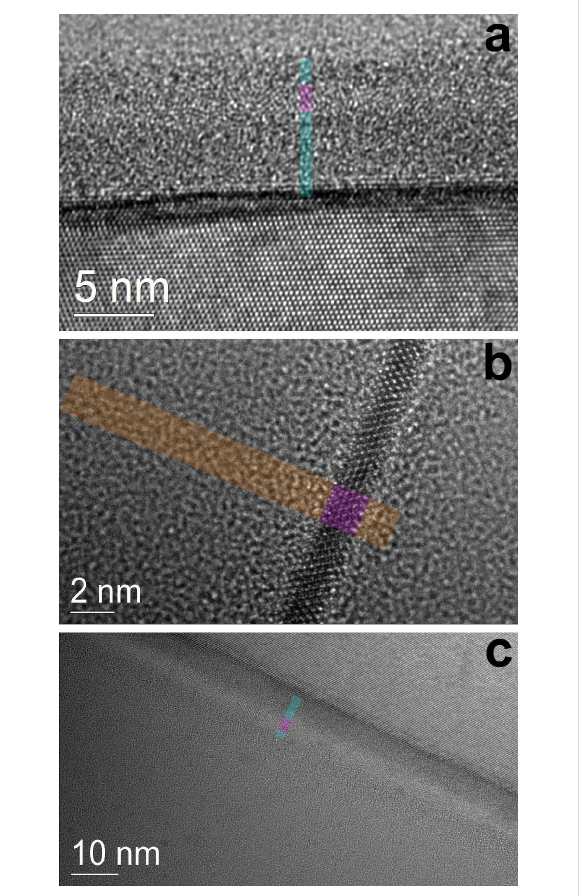
Figure 4: Cross-section HR-TEM images of samples QW-17-N (a), QW-17-O (b) and QW-26-N (c). Semi-transparent strips show layer thicknesses of Si 3 N 4 (cyan), Si-NWells (magenta) and SiO 2 (orange).